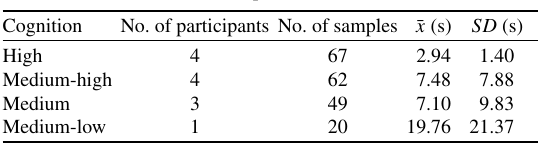
User selection: Perception times for 198 trials